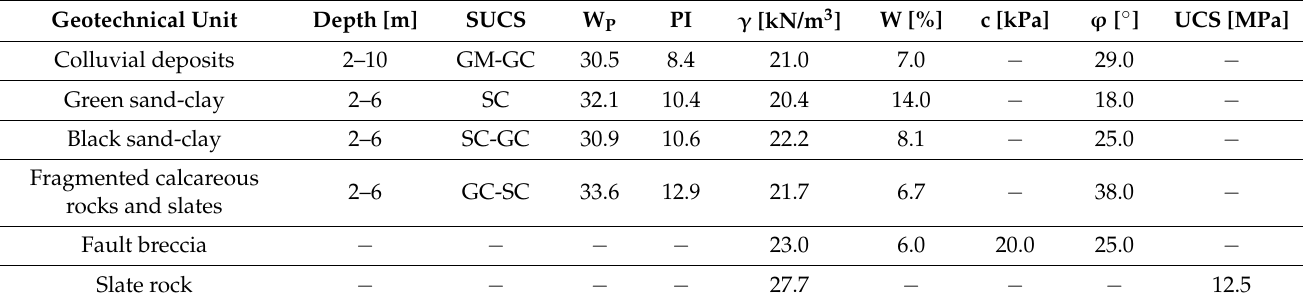
Table 1. Geotechnical parameters of the materials found in the area under study. Geotechnical